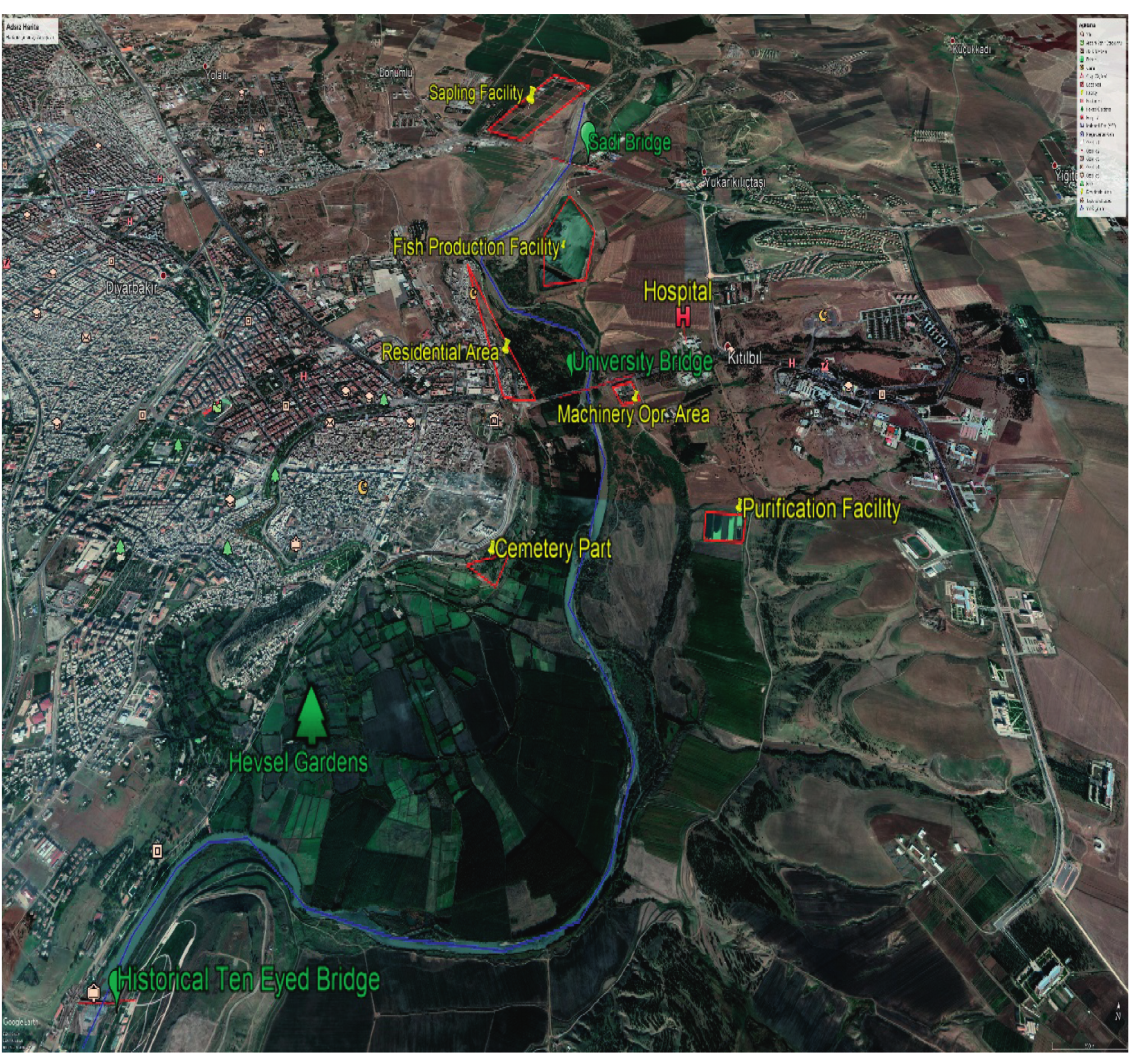
Figure 3: Tigris River studied route. Table 2: Roughness coefficient calculation in different parts of the Tigris